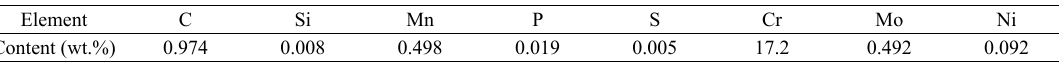
Figure 1. Mechanical drawing for the friction and wear of 9Cr18Mo Table 1. Chemical composition of 9Cr18Mo bearing steel.